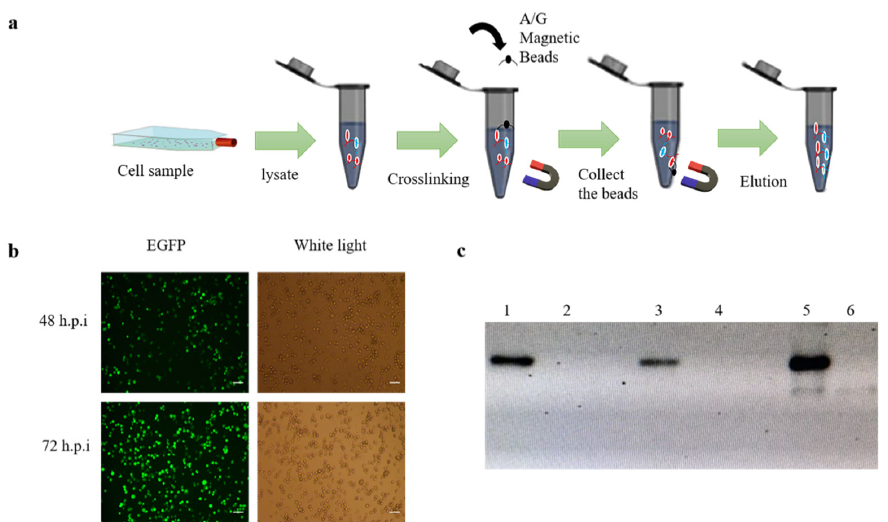
Figure 1. Co-immunoprecipitation of BmN sample. ( a ) Schematic diagram of co-immunoprecipitation of BmN cell. ( b ) Fluorescence image of infection of BmN cells at the stage of sample collection (bar = 100 μ m). ( c ) Qualitative analysis of proteins at different stages of immunoprecipitation. (1: Proteins of the lysed cells; 3: Protein not bound to magnetic beads; 5: Protein eluted from the mag- netic beads, and 2,4,6 is control).